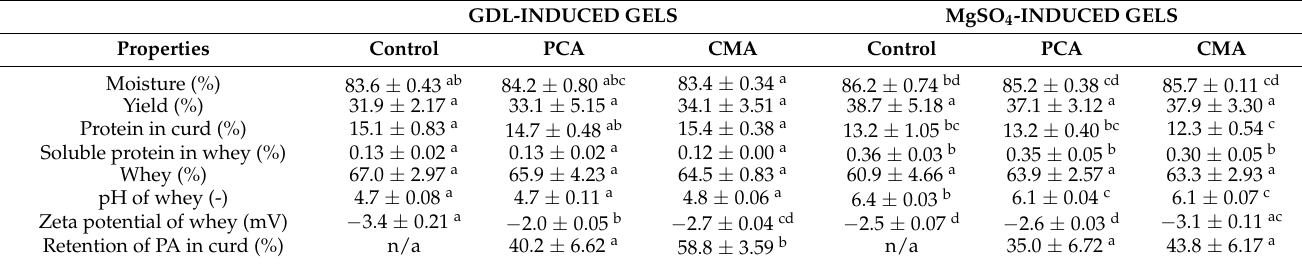
Table 1. Physical characteristics of two types of pressed soy protein gels induced by glucono δ -lactone (GDL) and MgSO 4 with added phenolic acids: protocatechuic acid (PCA) and coumaric acid (CMA). Values were represented as means ± standard deviations ( n = 3). a–d Different letters within the same row of six values indicate significant differences ( p ≤